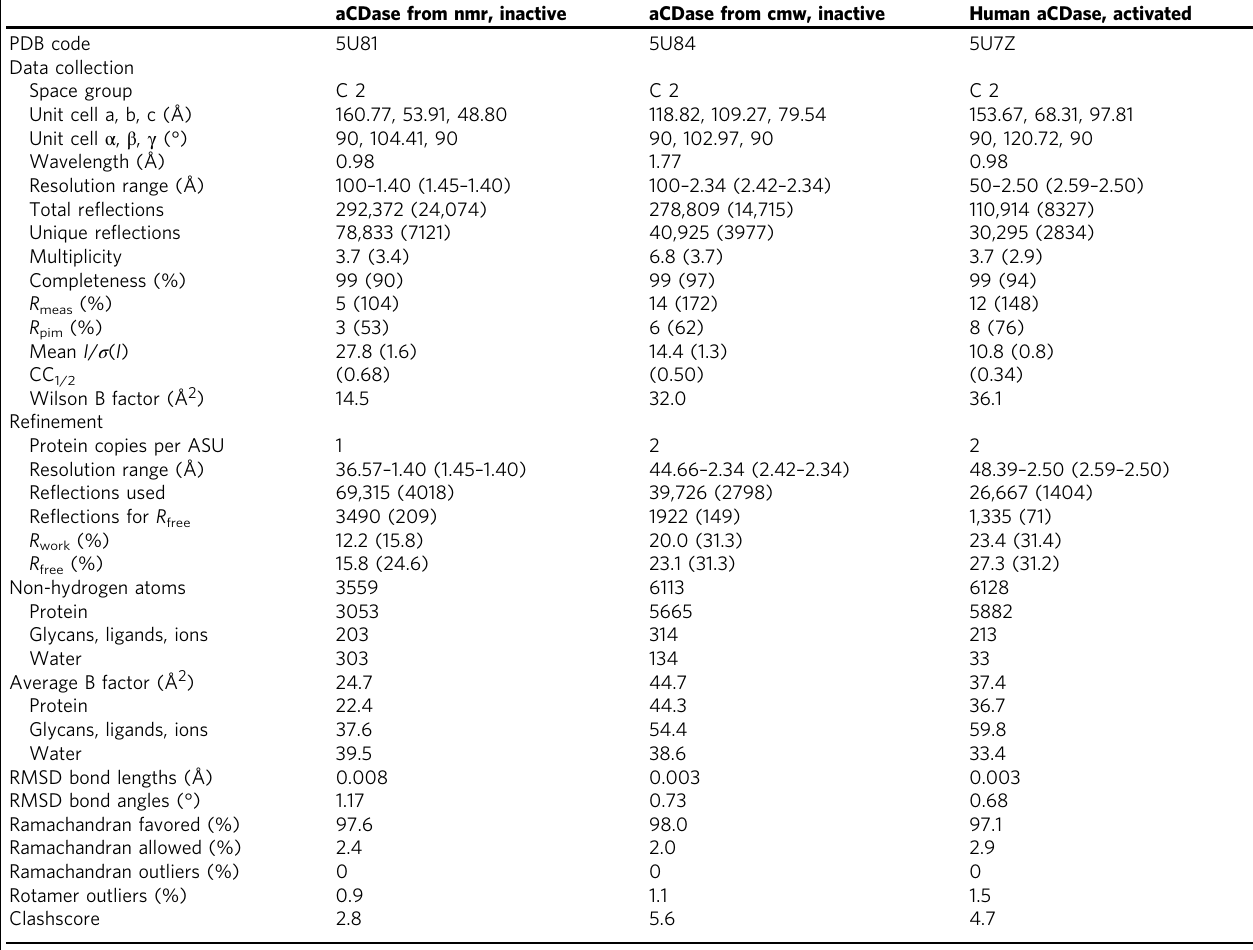
Table 1 Crystallographic data collection and re fi nement statistics aCDase from nmr, inactive aCDase from cmw, inactive Human aCDase,